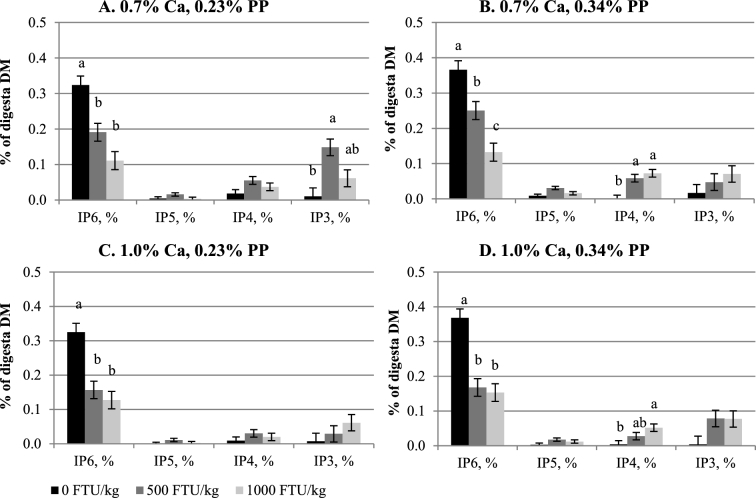
Effect of phytase on inositol phosphate ester (IP3–6) concentrations in proventriculus and gizzard (mean±SEM). On DM basis, analyzed IP6 and IP5 concentrations were 0.998 and 0.088%, respectively, in low PP basal, and 1.368 and 0.129%, respectively, in high PP basal. No IP3 or 4 concentration was detected in either low or high PP basals. a-c Comparisons were made within the same IP ester group. Means with different superscript letters differ.